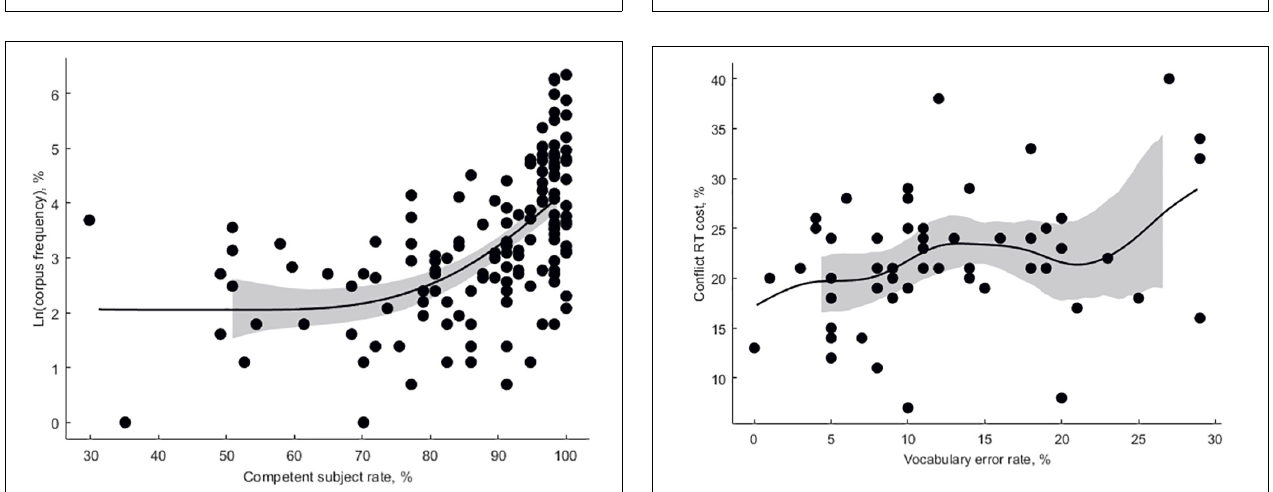
conflict effect rate. Vocabulary error rate correlated negatively